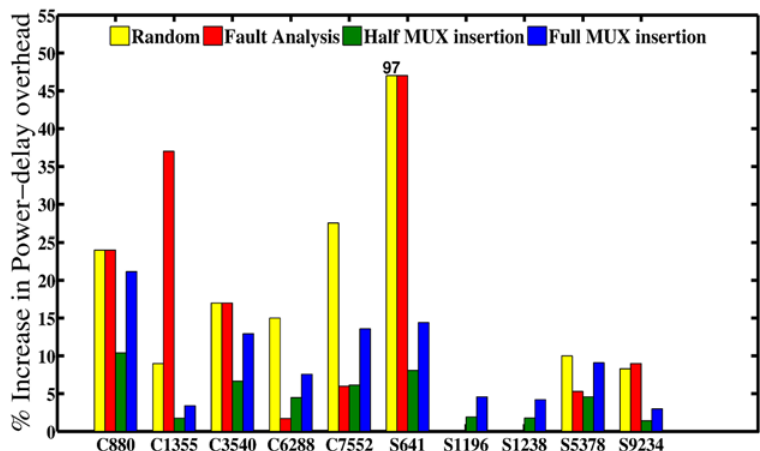
Figure 37. Comparing the power ‐ delay overhead of random, fault analysis, and full/half MUX insertions for logic encryption.